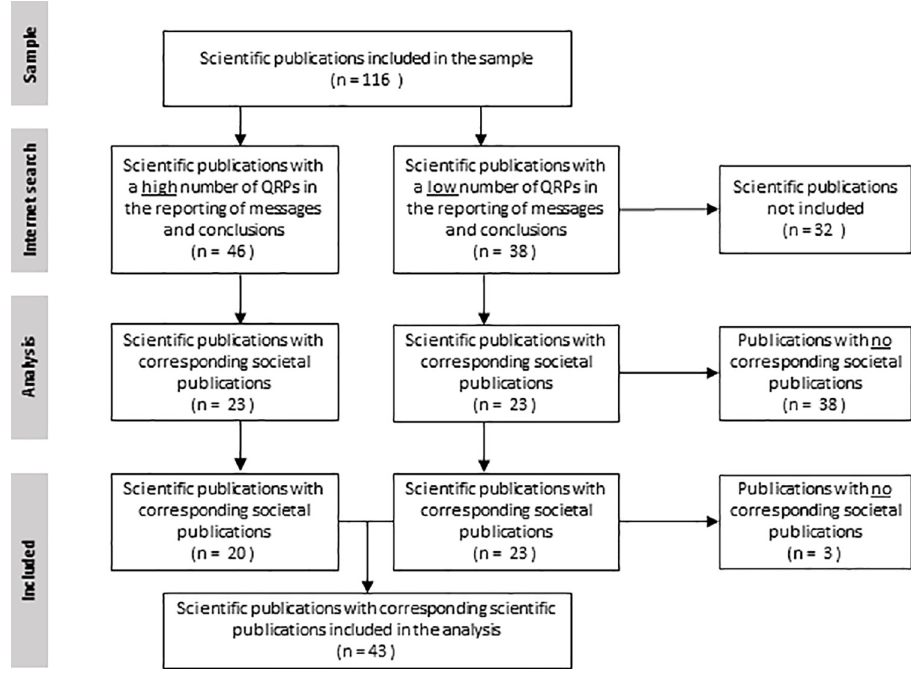
Fig 1. Flow chart inclusion and exclusion process.